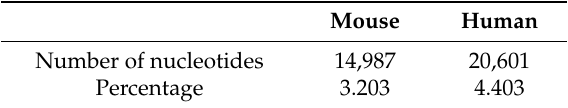
Table 2. Intronic Chicken nucleotides conserved in Mouse and